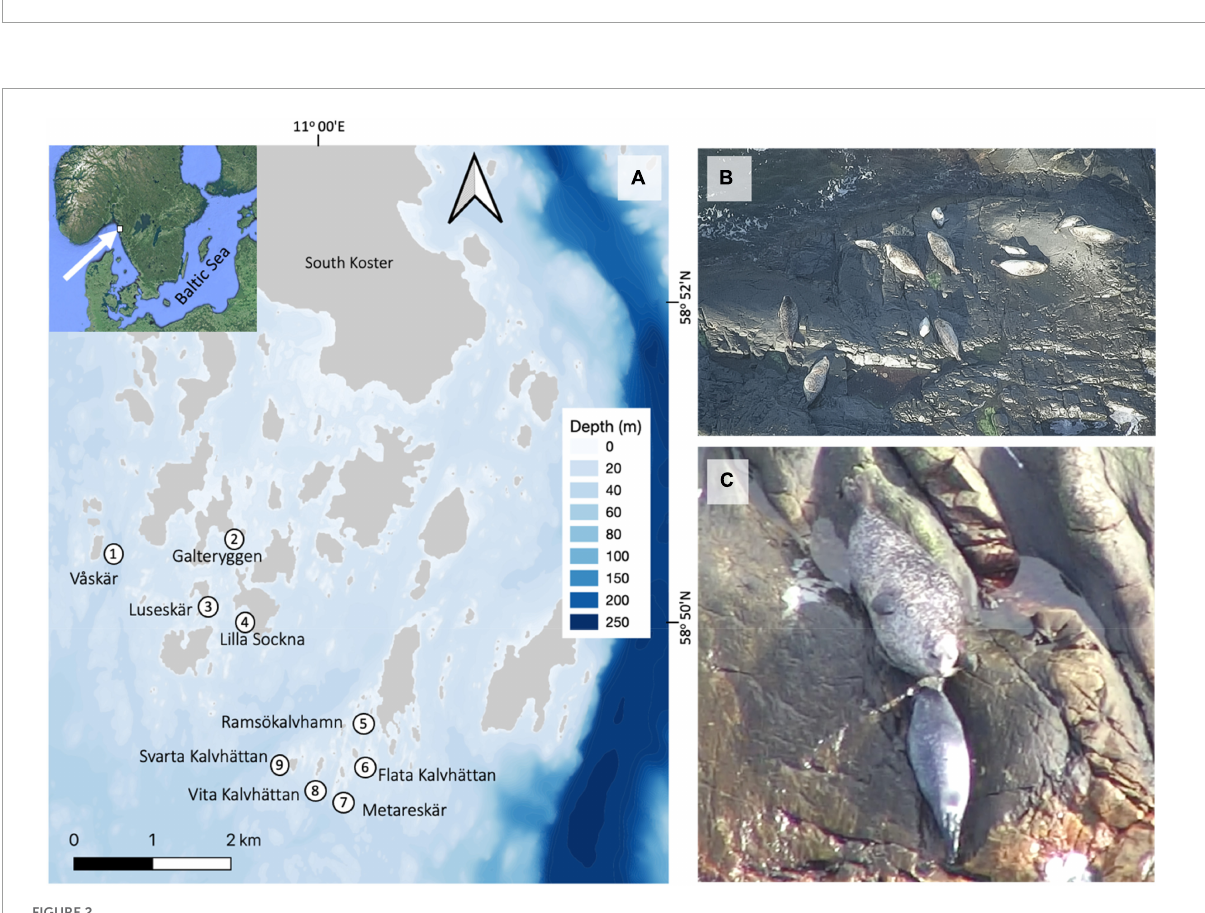
FIGURE2 (A) Map of the main haul-out sites for harbour seals in the Kosterhavet archipelago, Sweden. (B) Adult females and pups haul-out during the peak pupping season, and a pregnant female is observed at the bottom left side. (C) Female harbour seals closely watch over their pups during lactation, the first 3 weeks after birth. Mother-pup-pairs can be recognized from drone photos (Images from drone zoom-photo survey of Svarta Kalvhättan, 18th June